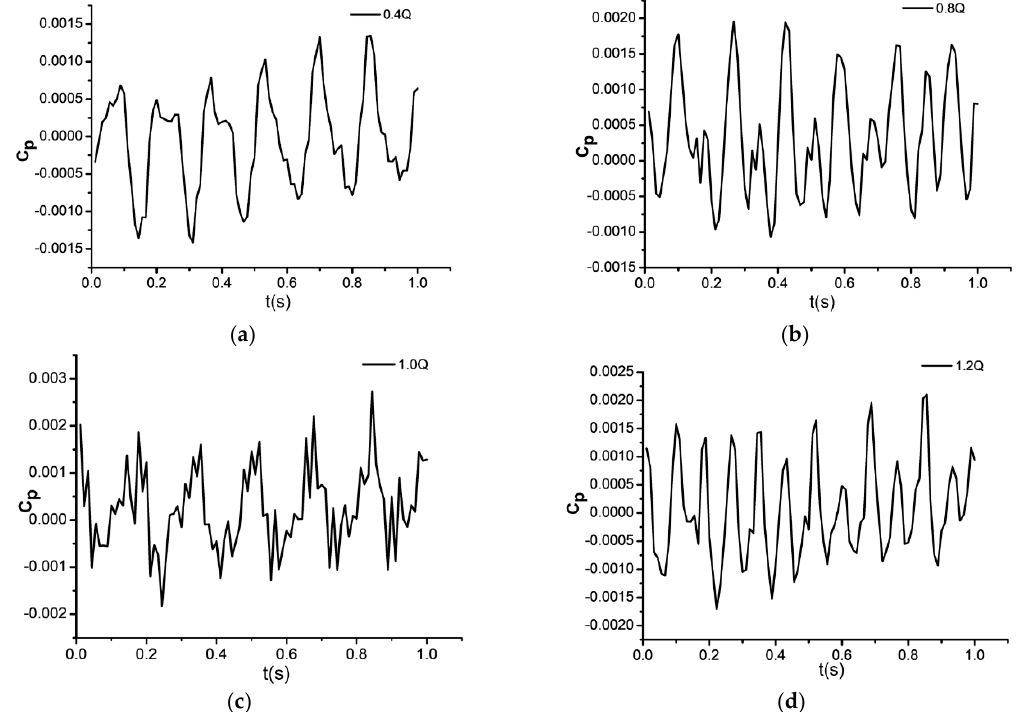
Figure 10. Pressure pulsation time domain in outlet pipe in different operating conditions. ( a ) 0.4 Q d . ( b ) 0.8 Q d . ( c ) 1.0 Q d . ( d ) 1.2 Q d .